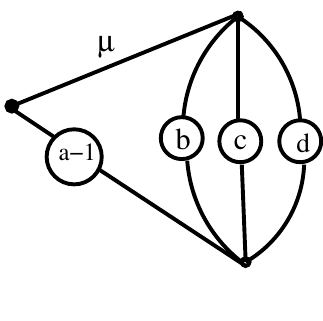
Figure 11 . A ( a ; b; c; d